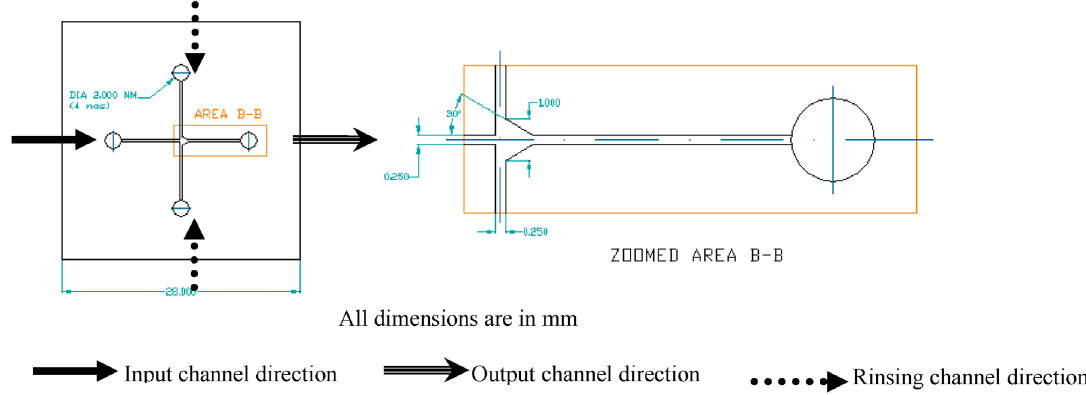
Figure 1. Features and dimensions of a master mold used for PDMS (polydimethylsiloxane) microfluidic chip.